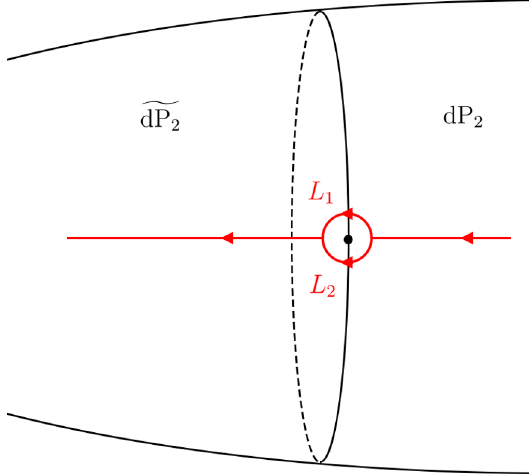
Figure 28 . Two paths crossing the marginal stability